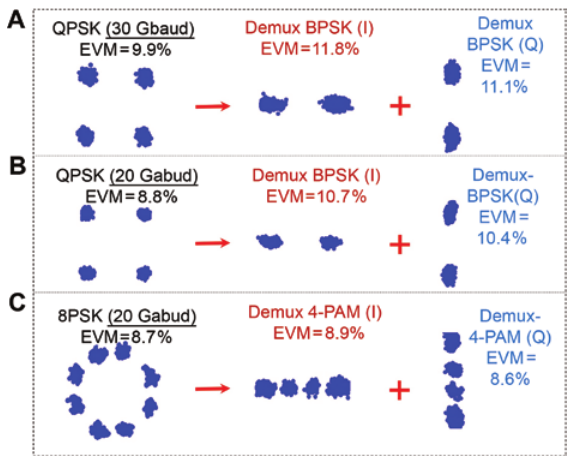
Figure 33: Deaggregation